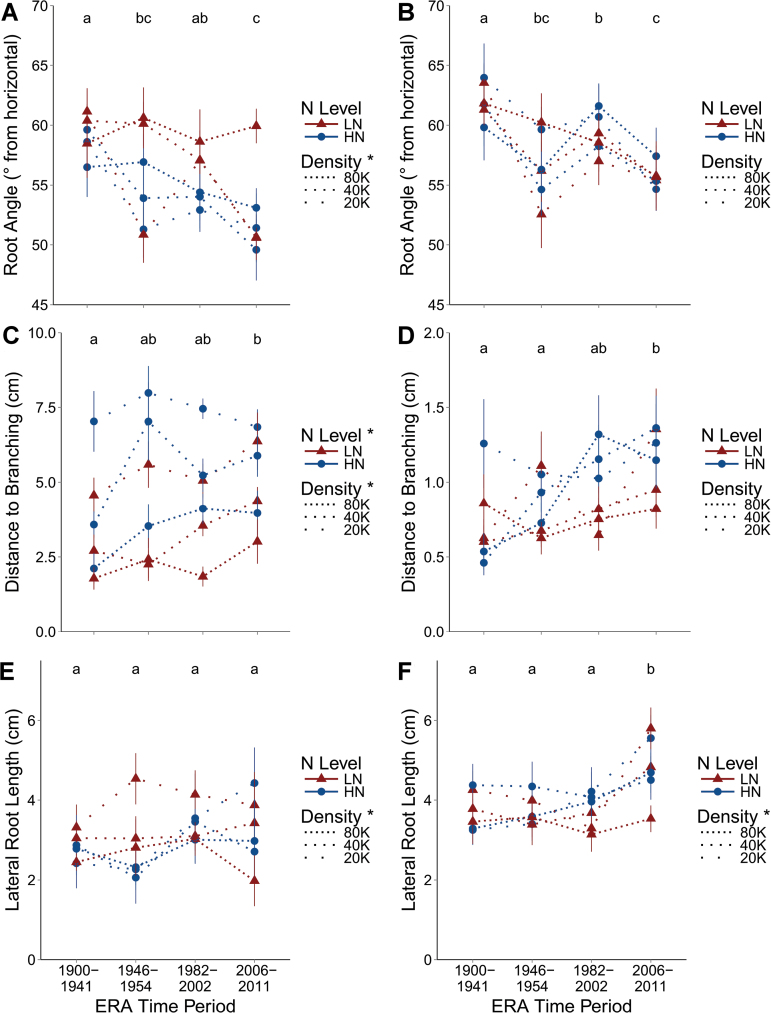
Brace (A) and crown (B) root angle are expressed as degrees from the horizontal such that larger angles are steeper. Distance to branching is the length along the nodal root from the stem to where lateral roots begin to emerge and is presented for brace (C) and crown (D) roots. Lateral root length was measured on three random lateral roots of the excised nodal root in each image and averaged before statistical analysis for brace (E) and crown (F) roots. Dotted lines represent planting density, with gaps between dots being proportional to differences in densities, with 20K, 40K, and 80K being 20 000, 40 000, and 80 000 plants ha–1, respectively. Triangles are in low nitrogen (LN) and circles in high nitrogen (HN). Points represent the mean of the four varieties in that Era time period in the specific N and density combination, and vertical lines the standard error. Letters demonstrate groupings from Tukey HSD mean comparisons among Era time periods (no differences indicate an insignificant effect of Era period). Presence or absence of an asterisk next to a treatment in the key indicates whether a treatment effect is significant or not, respectively. (This figure is available in colour at JXB online.)